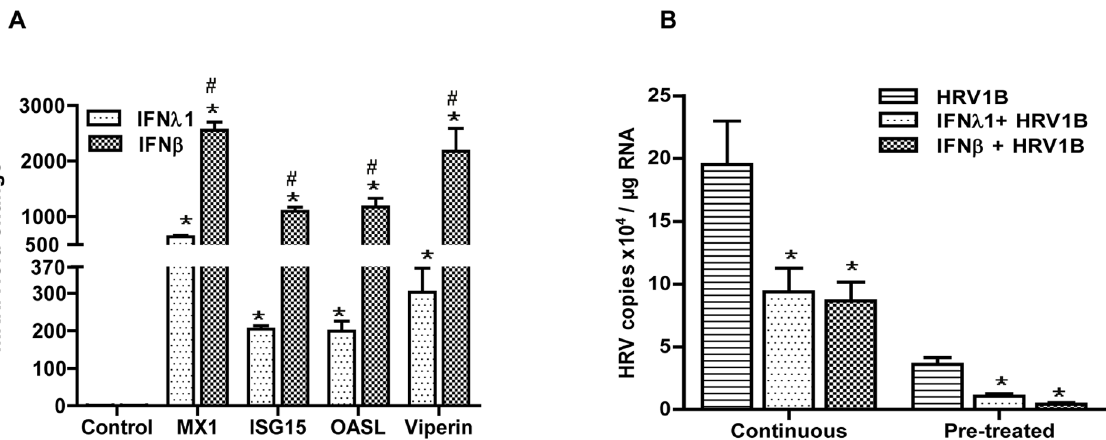
Figure 1. IFN-induced antiviral state protects against HRV1B infection in A549. A549 were treated with IFNs for 18 h and then mRNA expression of different ISGs was determined by qPCR (n=6). Fold-changes were calculated with the 2 2 DD Ct method (A). A549 were first treated with IFNs for 18 h. Next, according to the continuous and pre-treatment approaches, cells were infected with HRV1B and incubated for another 24 h (n=6). After that, cells were collected for further analyses. Viral copies were determined by qPCR and fold-changes were calculated with the 2 2 DD Ct method (B). *, p , 0.05 Control vs IFNs, HRV1B vs IFNs + HRV1B. # p , 0.05 IFN- l 1 vs IFN- b .